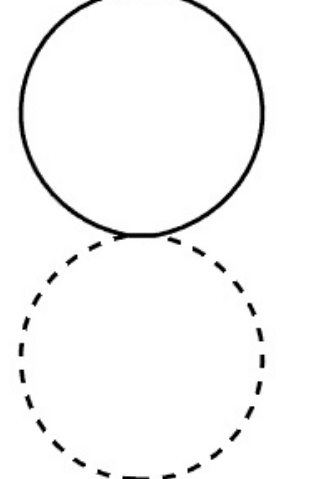
Figure 17. Contact between two bodies analyzed with the IGA-BEM and the optimization proposed.